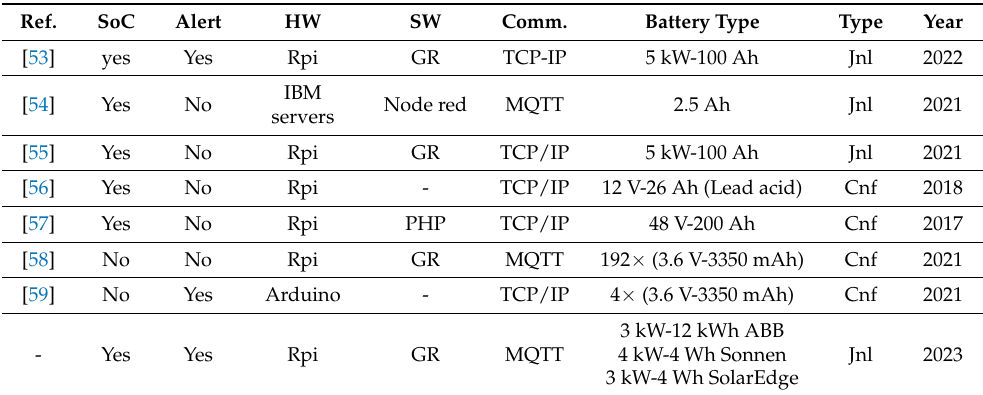
Table 1. Comparison of main features of previous